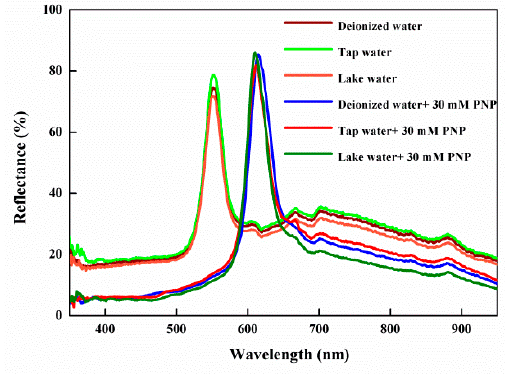
Figure 7. Optical response of the IOPPCs in tap water and lake water.